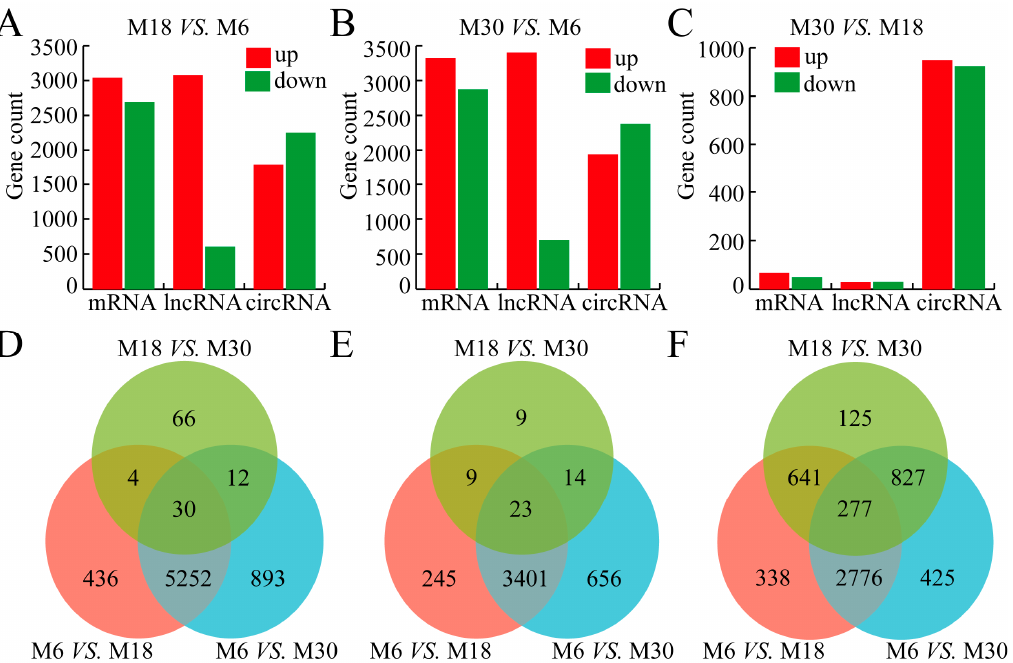
Figure 2. Comparative analysis of mRNAs, lncRNAs, and circRNAs in different developmental stages of yak testis. ( A ) Histogram representing the numbers of upregulated and downregulated mRNAs and ncRNAs between 18 and 6-month groups. ( B ) Histogram representing the numbers of upregulated and downregulated mRNAs and ncRNAs between 30 and 6-month groups. ( C ) Histogram representing the numbers of upregulated and downregulated mRNAs and ncRNAs between 30 and 18-month groups. ( D ) The number of common DE mRNAs. ( E ) The number of common DE lncRNAs. ( F ) The number of common DE circRNAs.